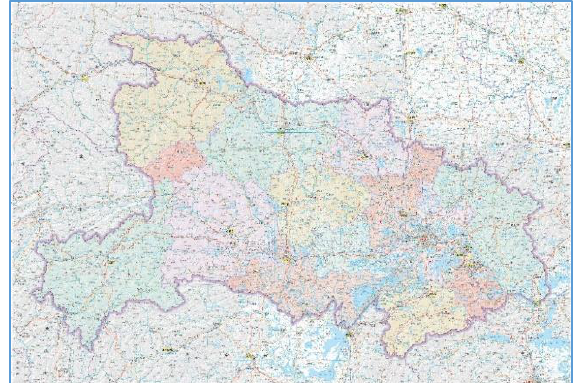
Figure 5. The topographic features map of Heilongjiang